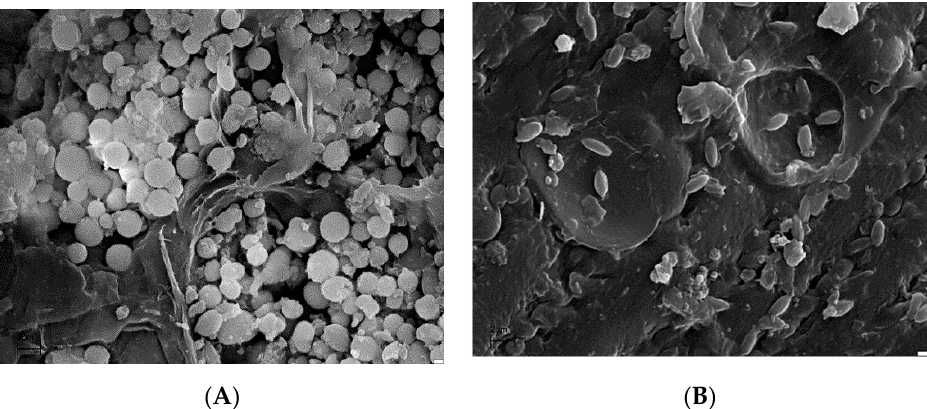
Figure 8. The change in zeta potential with equilibrium pH.